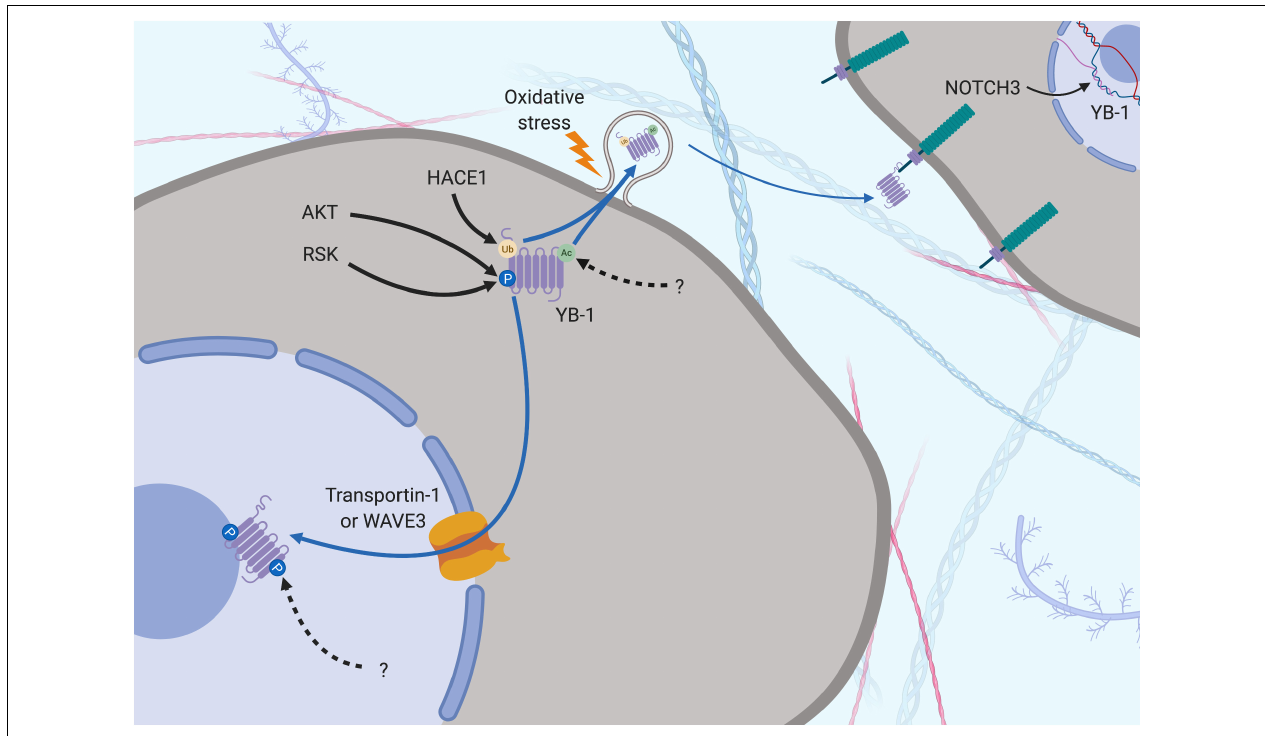
FIGURE 5 | Subcellular localization of YB-1 – the phosphorylation theory of nuclear localization. YB-1 can be found in the nucleus, cytoplasm and extracellular space and its localization is mediated by various factors. Secretion can be preceded by Ubiquitination (orange dot) by HACE1 and acetylation (green dot) by a currently unknown protein. Oxidative stress stimulates stress-granule localization and eventual section of YB-1, where it can bind to the transmembrane protein Notch3 on other cells. Phosphorylation is required before nuclear shuttling can take place. Ser102 is phosphorylated by upstream kinases, changing the configuration of YB-1 to block the CRS and allow nuclear shuttling via Transportin-1 or WAVE3. Phosphorylation of Tyr281 by a currently unknown upstream regulator may play a role here too. Solid black arrows indicate a post-translational modification that is produced by a described or known mechanism. Dotted black arrows indicate a post-translational modification whose significance is yet to be realized. Blue and dotted blue arrows indicate the movement or supposed movement of YB-1 throughout cellular compartments, respectively. Created with